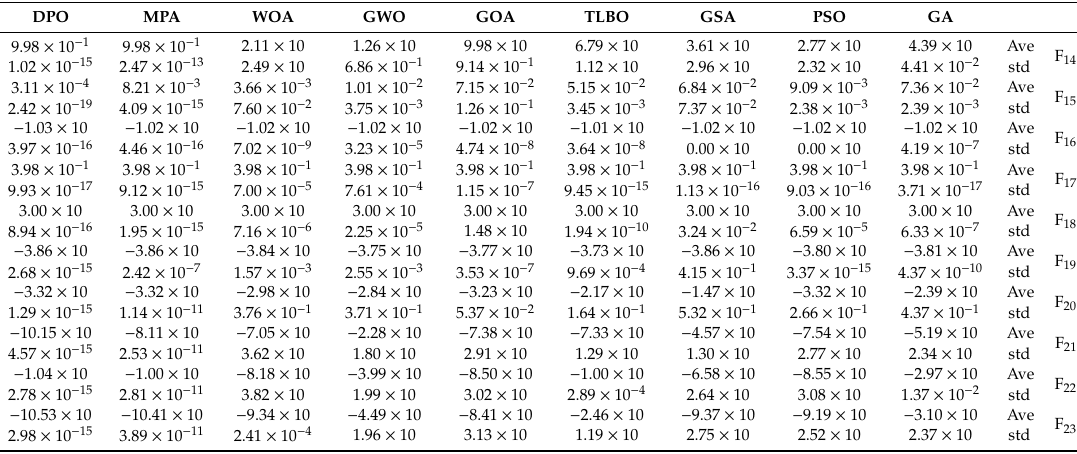
Table 3. Optimization results on multimodal test functions with low